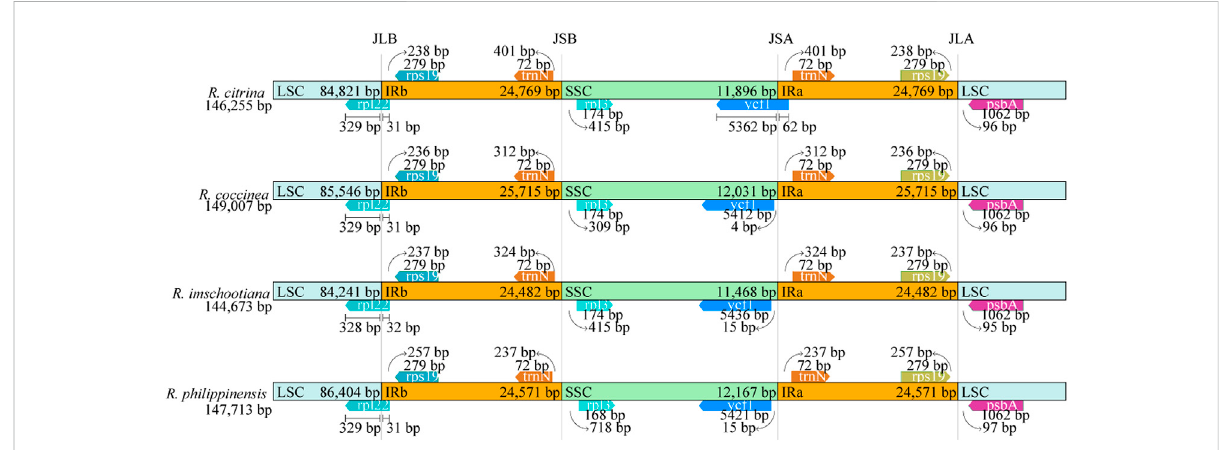
FIGURE 3 Comparison of the junctions of LSC, SSC, and IR regions among four plastid genomes of Renanthera